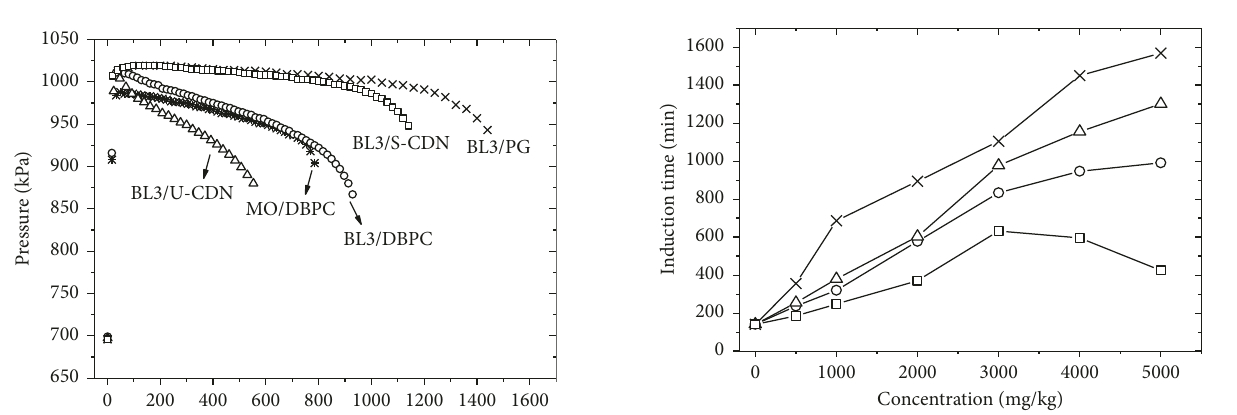
Figure 8: Experimental induction times of BL3 as a function of antioxidants concentrations. □ , U-CDN; △ , S-CDN; ◯ , DBPC; × ,